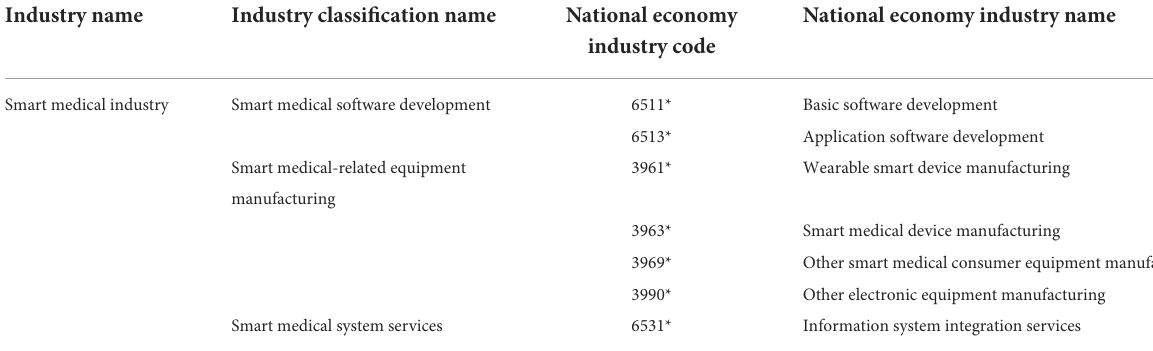
TABLE 1 Classification of the smart medical industry in strategic emerging industries